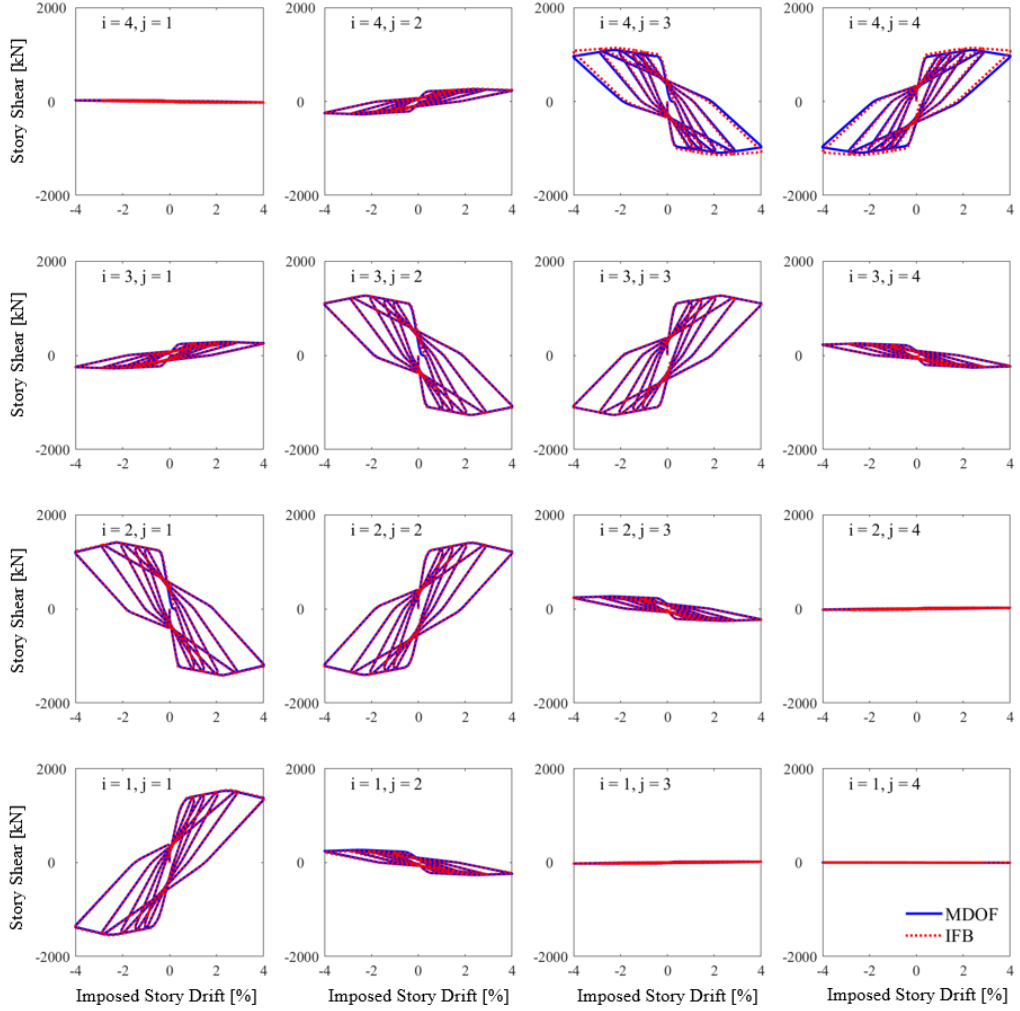
Figure 7. Storey shear – storey drift relationship based on imposed displacement analyses, both types of building models (i.e., IFB and MDOF model) in the i-th storey for the imposed displacements in j-th storey of 4F building.